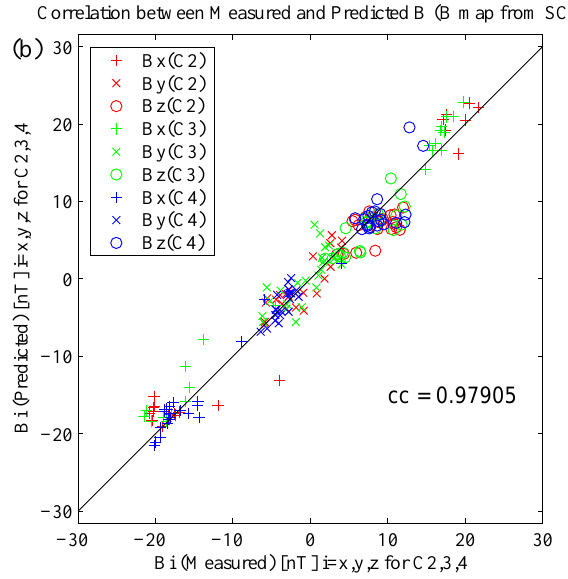
Fig. 4. (a) Time series of intensity and three components of the measured (solid) and predicted (dashed) magnetic field data (nT) in the reconstruction coordinates. The predicted data are based on the field map recovered from the C1 data (Fig. 3). (b) Correlation between the measured and predicted magnetic field components. The x , y , and z components in the reconstruction coordinates are represented as a plus, a cross, and a circle, respectively. The curves and points are color-coded as in Fig.